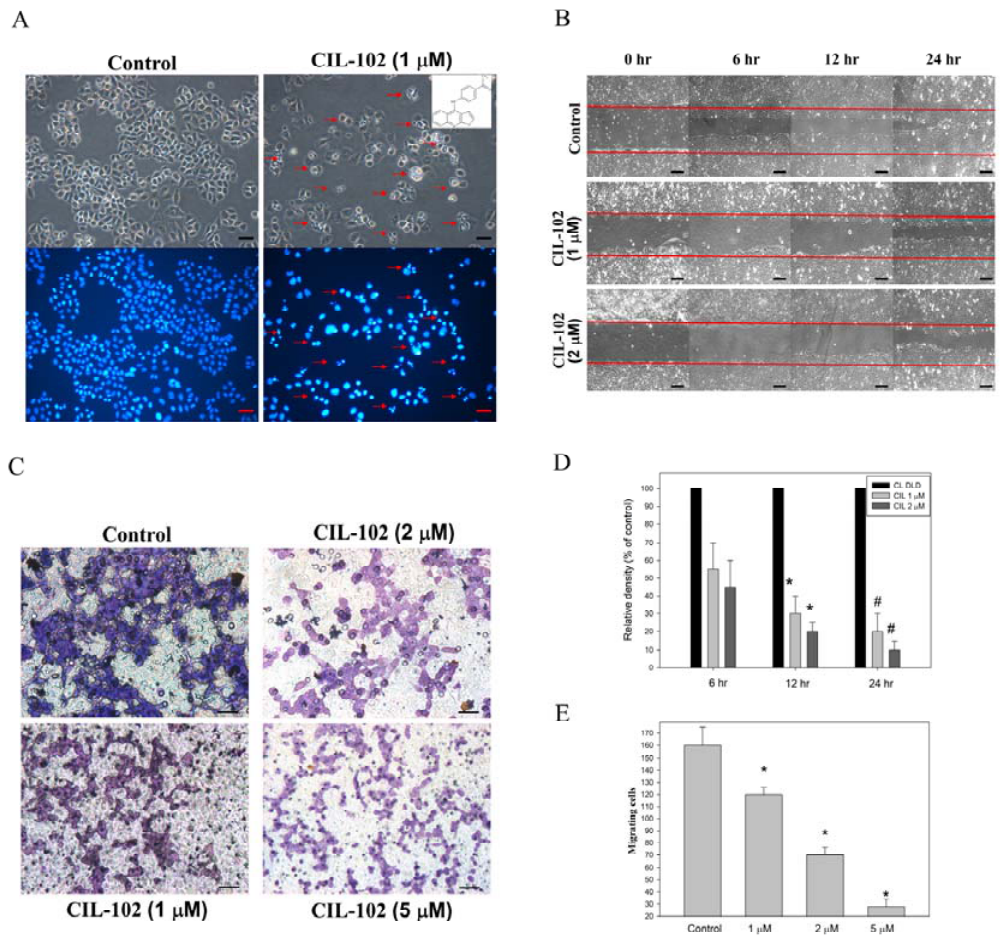
Figure 1. CIL-102 treatment impairs cell migration and the invasiveness of human colorectal cancer cells. ( A ) DLD-1 cells were treated with either 0.1% DMSO (as control) or CIL-102 (1 µ M) for 24 h. The morphological characteristics (nuclear condensation) of the apoptotic cells were measured by DAPI staining under fluorescence microscopy. The red arrow indicates the apoptotic cells. ( B , D ) The migration of treated DLD-1 cells, with or without CIL-102 (1 and 2 µ M), was performed for 6, 12, and 24 h and visualized by scratch-wound assay, as described in the Methods section. The quantification of the filled surface area with DLD-1 cells was done by using densitometric analyses. Data are presented as a percentage of the control group (means ± SD), based on three independent experiments in triplicate. Control VS CIL-102, * p < 0.05, compared with the control group for 12 h; # p < 0.01, compared with the control group for 24 h. ( C , E ) Invasiveness of DLD-1 cells treated with various concentrations (1, 2, 5 µ M) of CIL-102 for 24 h was detected by the Boyden Chamber method, as described in the Methods section. The lower and upper chemotaxis cells were separated by a polycarbonate membrane. The representative images of cell invasion were detected through a layer of matrigel into the inner membrane under microscopy. Magnification × 200. The number of cell invasions into the inner membrane was quantified by manual counting and the data are presented as means ± SD. Control cells indicate the cells with a saline treatment. The experiments were performed in triplicate. * p < 0.05, compared to the untreated control cultures.